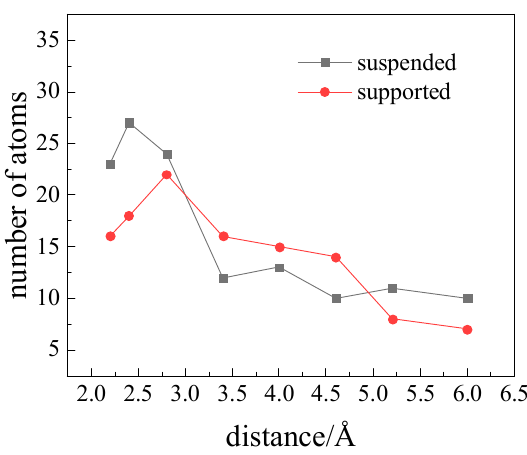
Figure 6. The relationship between defect and irradiation density of suspended and supported SLG (irradiation energy of 4.41 keV; irradiation dose of 25).